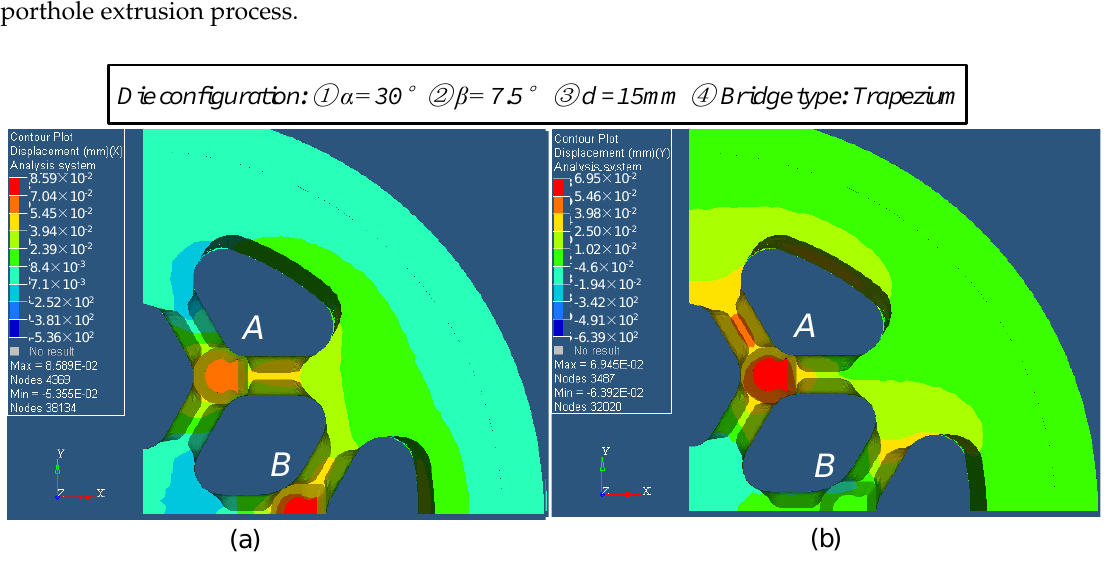
Figure 9. The mandrel deflections of the upper die: ( a ) X -displacement, ( b ) Y -displacement.